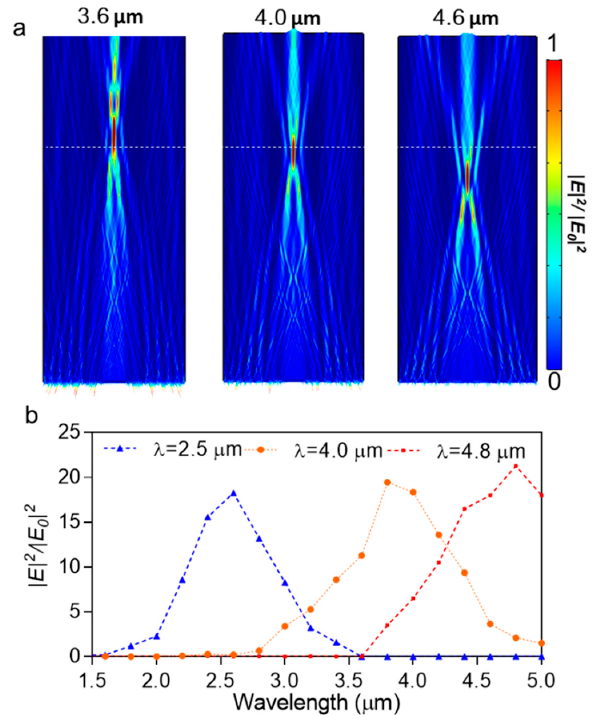
Figure 4. ( a ) Simulated light intensity distribution of a meta-lens with NA of 0.43 with light at different wavelength. ( b ) Spectral enhancement factors across the focused area for meta-lens designed for 2.5, 4.0, and 4.8 μ m (dashed line in Figure 3a).